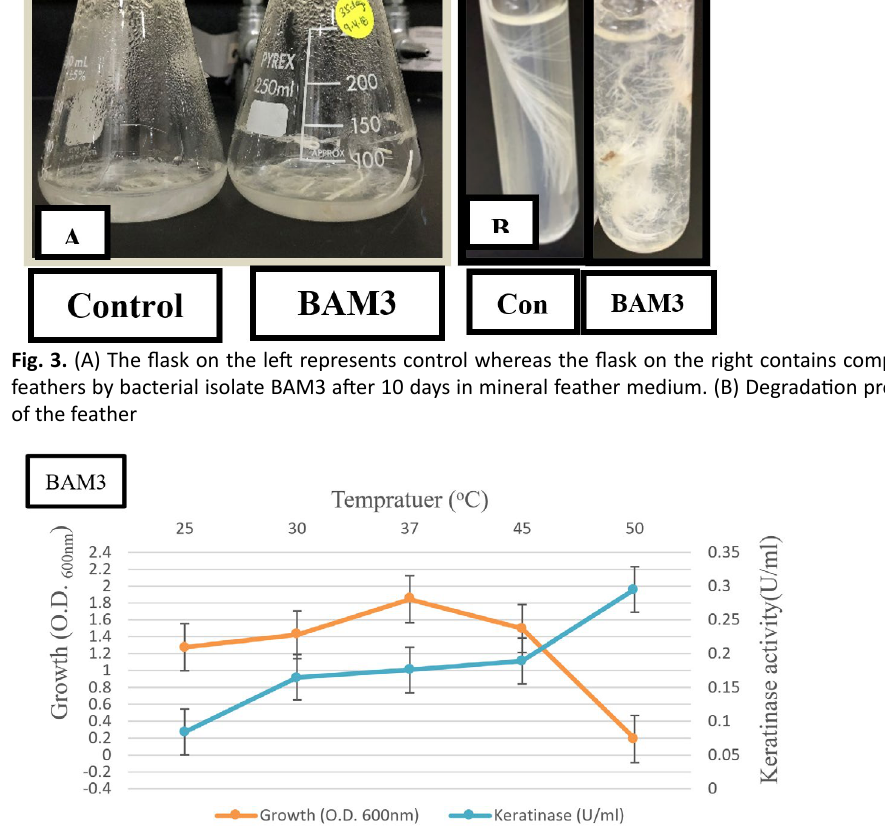
Fig. 4. The effect of temperature on the production of keratinase by isolate